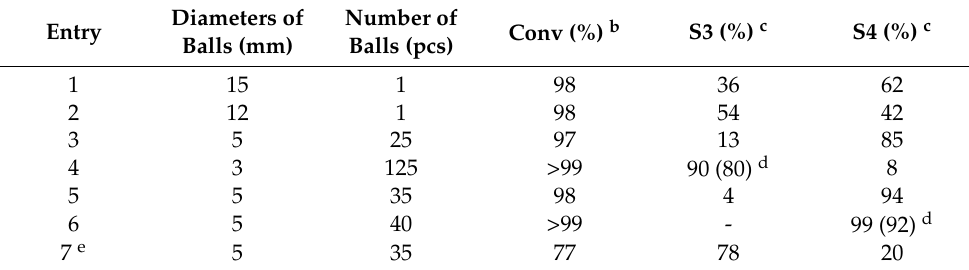
Table 3. Effect of the size and number of grinding balls in the reaction of 1 and 2 a .